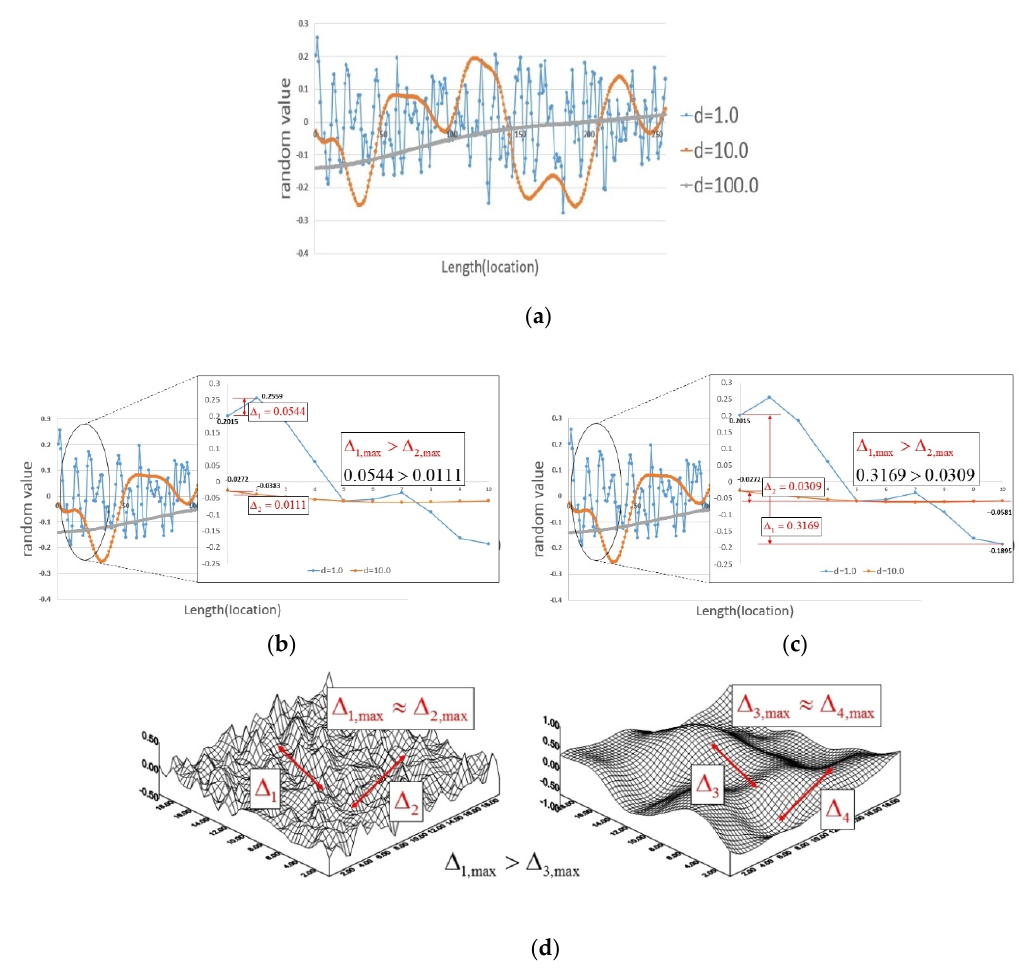
Figure 5. Difference of value between random variables: ( a ) Stochastic fields (1D-1V); ( b ) Difference of value in two continuous variables; ( c ) Difference of value in two non-continuous variables; ( d ) Comparison in stochastic fields with different correlation distance.